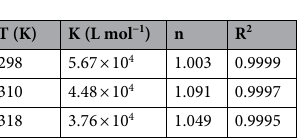
Table 2. MBZ-BSA complex binding characteristics at different temperatures.